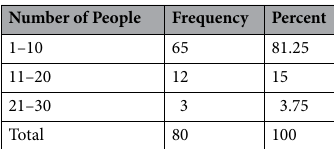
Table 3. Breakdown of Employment in